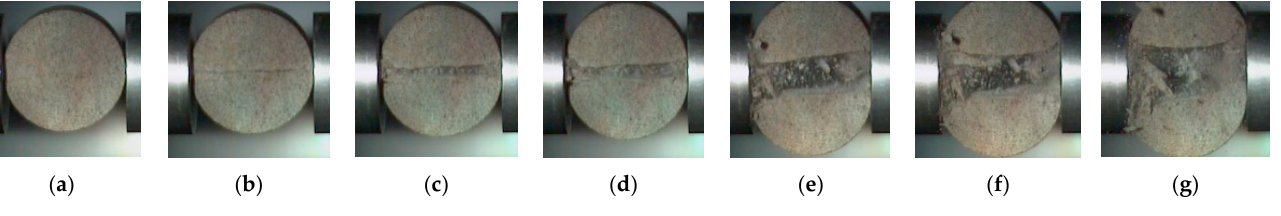
Figure 11. High-speed camera and its supporting instruments and equipment.